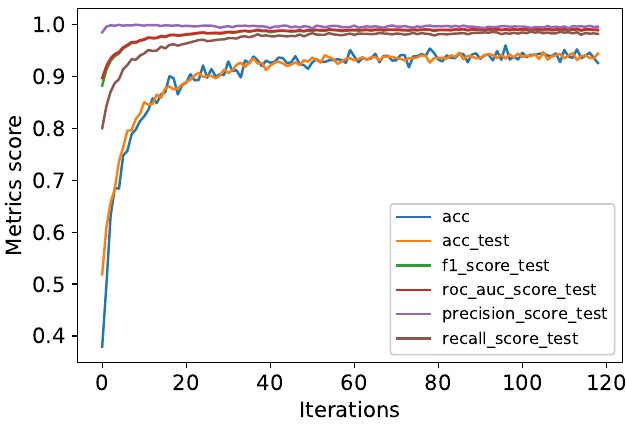
Figure 11. Accuracy results for different